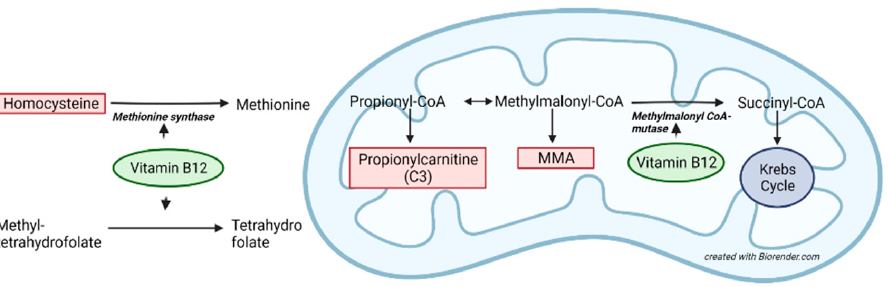
Figure 1. The two vitamin B12-dependent pathways (simplified) in the cytosolic and mitochondrial compartments of the cell. MMA; methylmalonic acid.